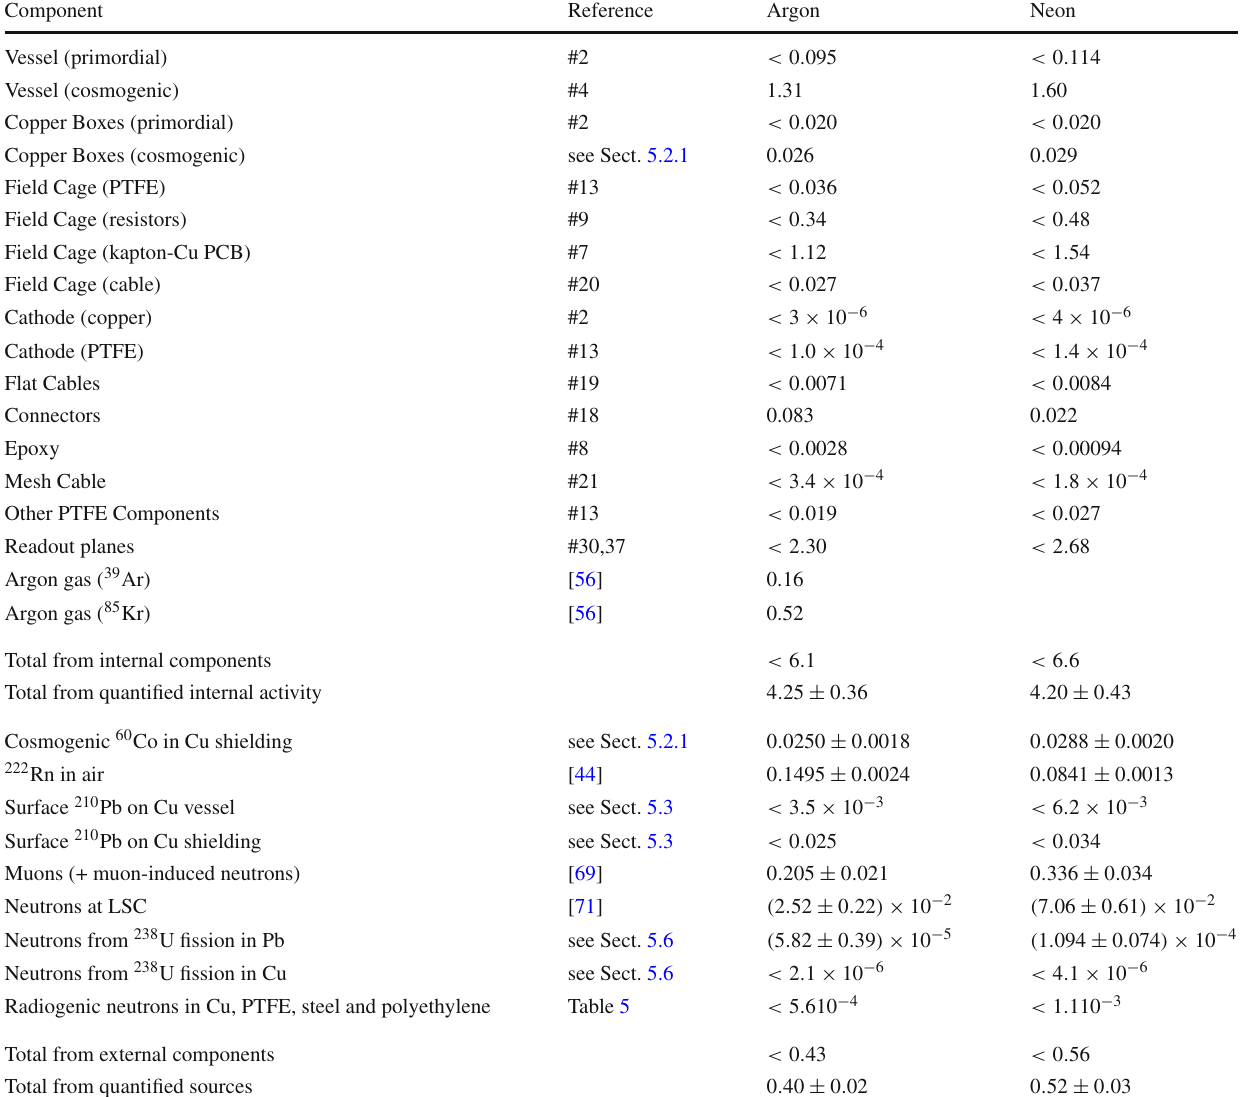
Table 2 Background rates (in counts keV − 1 kg − 1 d − 1 ) expected in the RoI(0.2–7keV ee )fromactivityincomponentsandbackgroundsatLSC using Ar or Ne mixtures in TREX-DM. The numbers with # at the sec- ond column refer to Table 1, indicating the activity values considered.